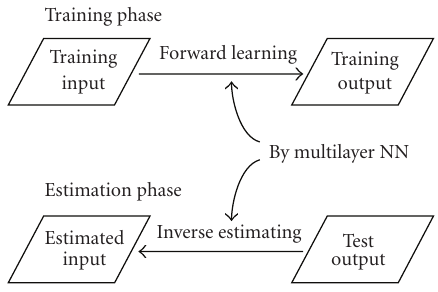
Figure 4: Two-step procedure to solve inverse problem by using network inversion.